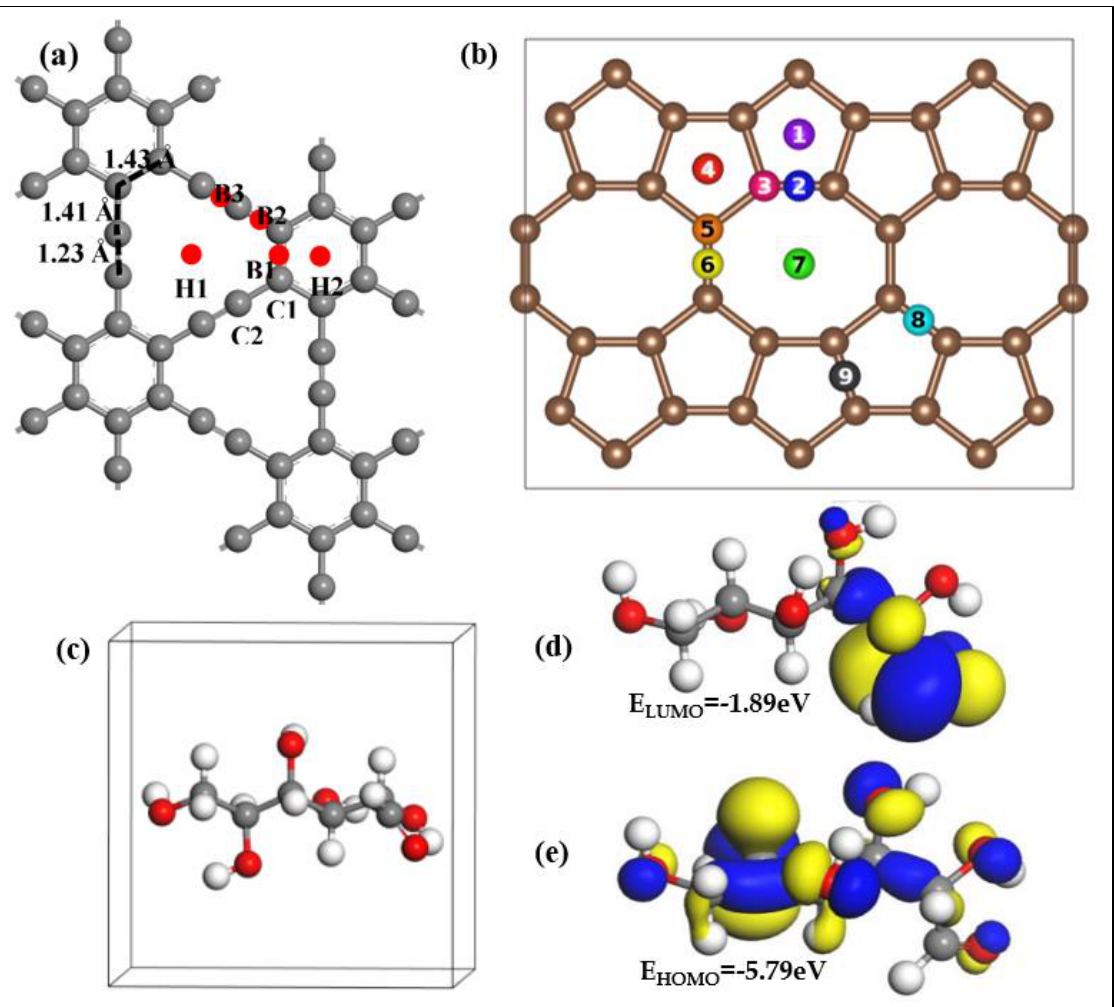
Figure 11. DFT optimized structures of ( a ) Graphyne, Reprinted from Ref. [182]. ( b ) POP-graphene with various adsorption sites, Reprinted from Ref. [183]. ( c ) D-glucose molecule and ( d , e ) HOMO and LUMO plots of D-glucose molecule. Reprinted from Ref. [184].